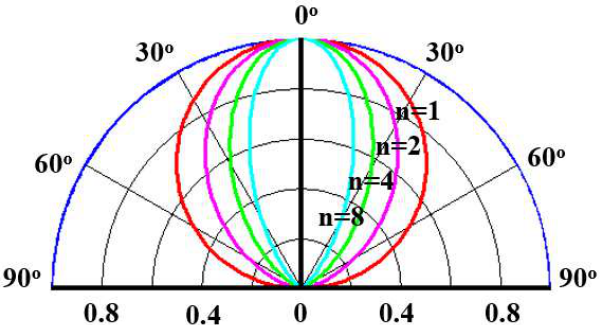
Figure 1. Theoretical leaf-shaped vapor clouds for different cosine exponents calculated using MathCAD.